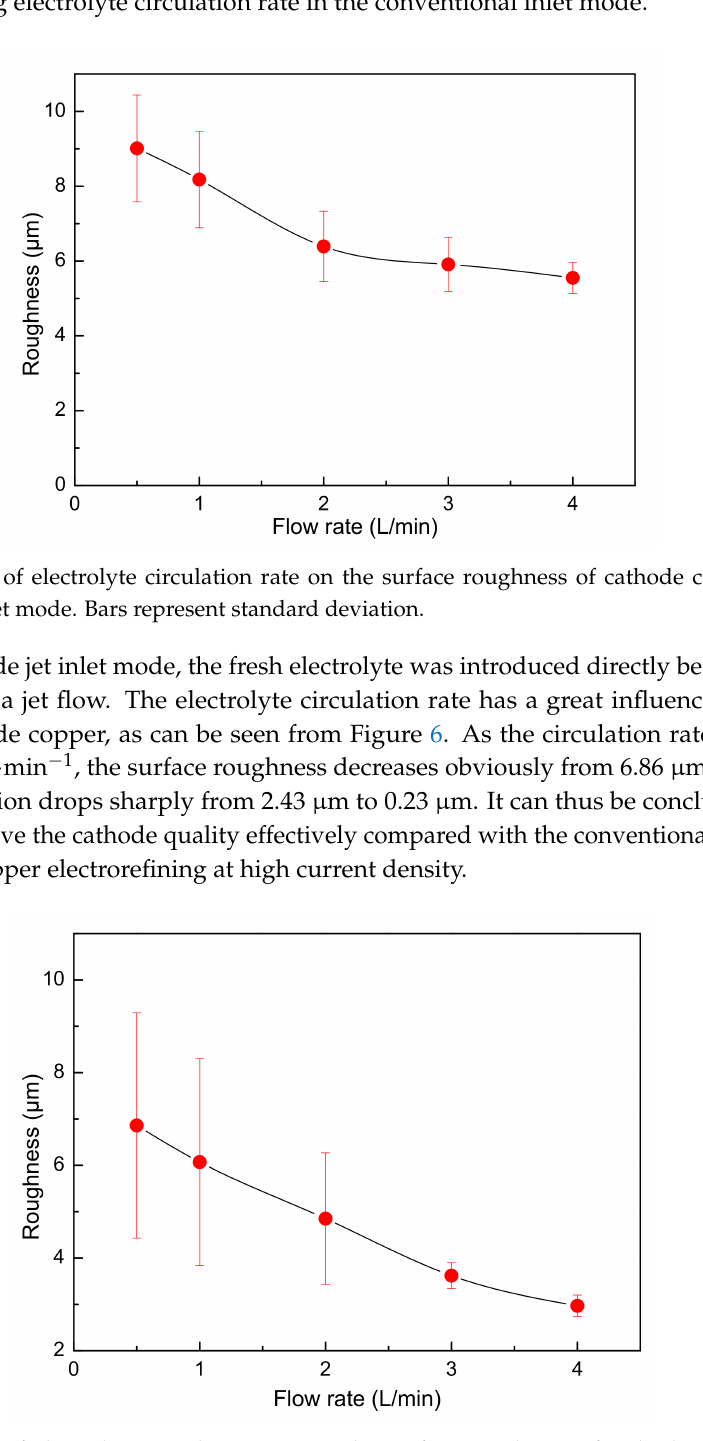
Figure 6. Effect of electrolyte circulation rate on the surface roughness of cathode copper. Bars represent standard deviation. The position of the single-side jet inlet was at the No. ii nozzle as shown in Figure